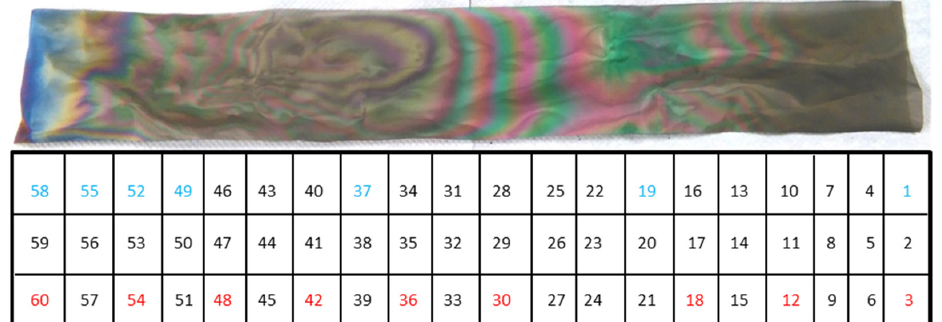
Figure 3. TiO 2 -SSM sample and the schematic partition enumeration. The total length of the mesh is 40 cm. The sample numbers marked in red were used for SEM and XRD analyses, while the blue ones for the photocatalytic tests.